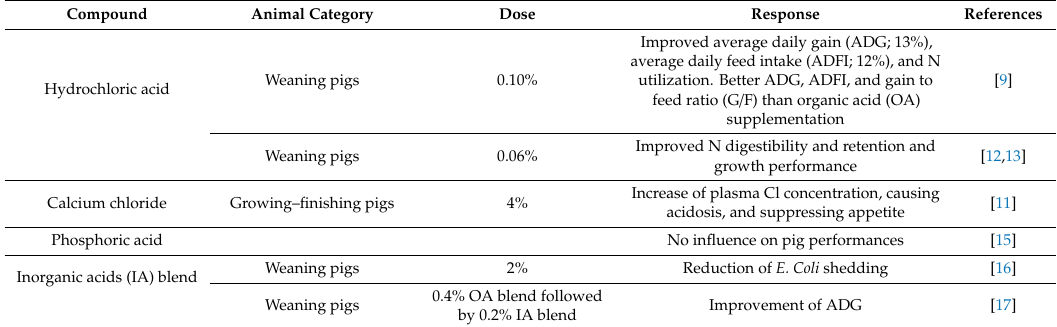
Table 1. Summary of studies about the most common inorganic acids used in pig